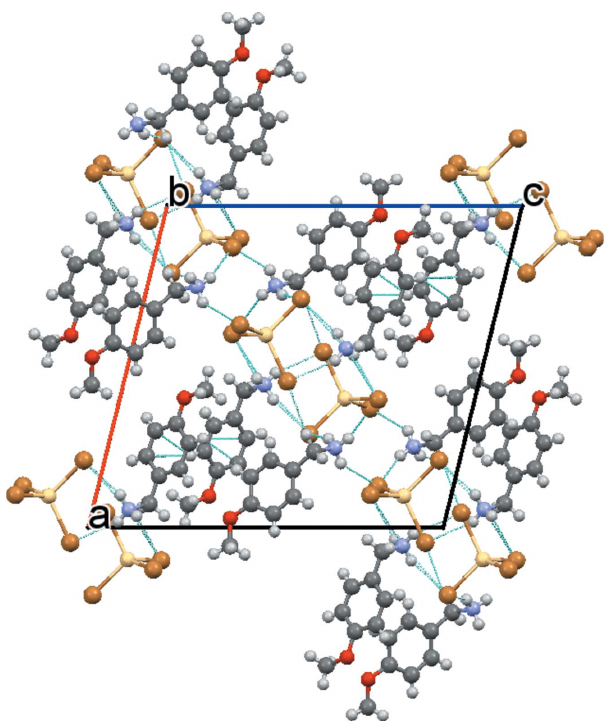
Figure 2 Packing diagram of the title compound viewed along the b axis, showing the alternate stacking of the organic and inorganic layers. Dashed lines indicate hydrogen bonds.